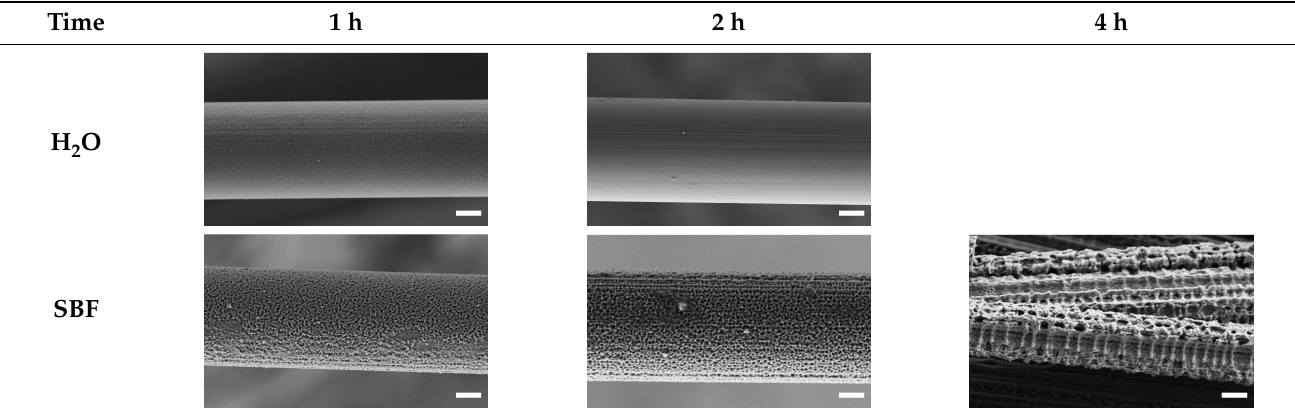
Table 10. SEM images of the dissolution of the fibres of the glass 13-93 (scale bars 2µm).